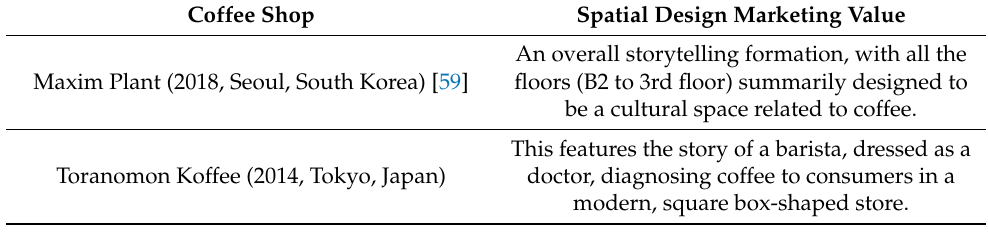
Figure 9. Earth Us (2017, Seoul, Korea).